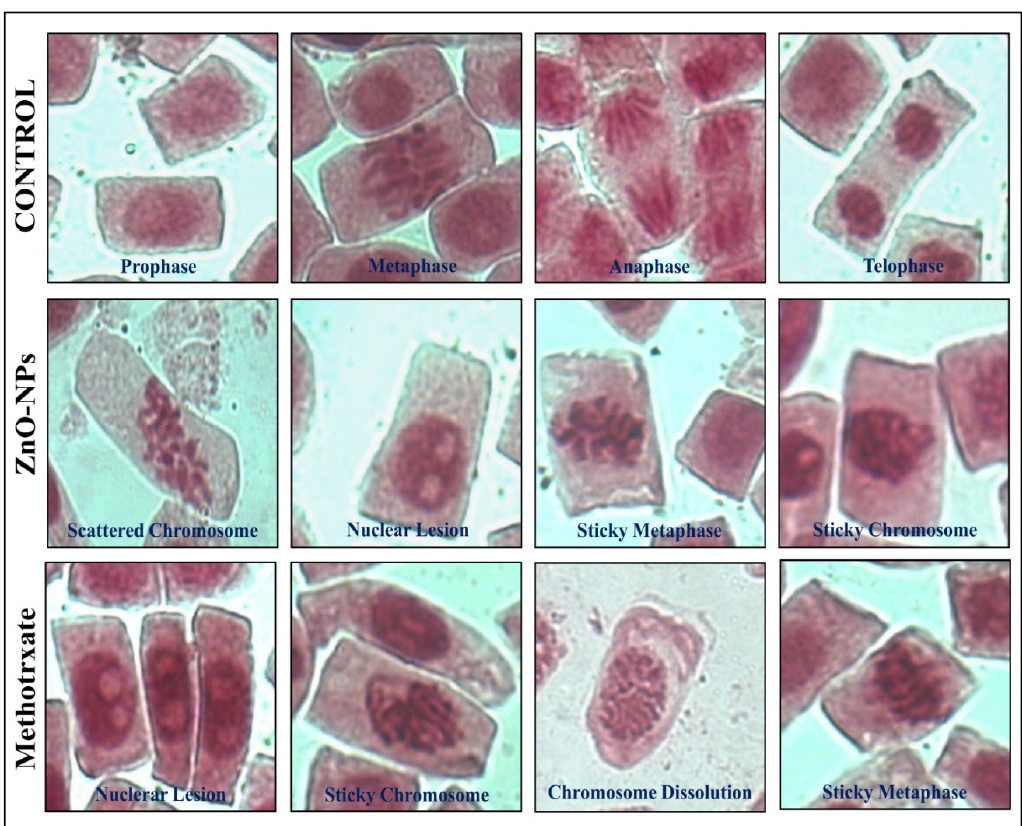
Figure 7. Genotoxic potential of phyto-fabricated ZnO-NPs from I. obscura aqueous leaf extract. Each value is the mean for three replicates (n = 3) and bars sharing the same letters are not signifi- cantly different ( p ≤ 0.05) according to Tukey’s HSD. The vertical bar indicates the standard error.